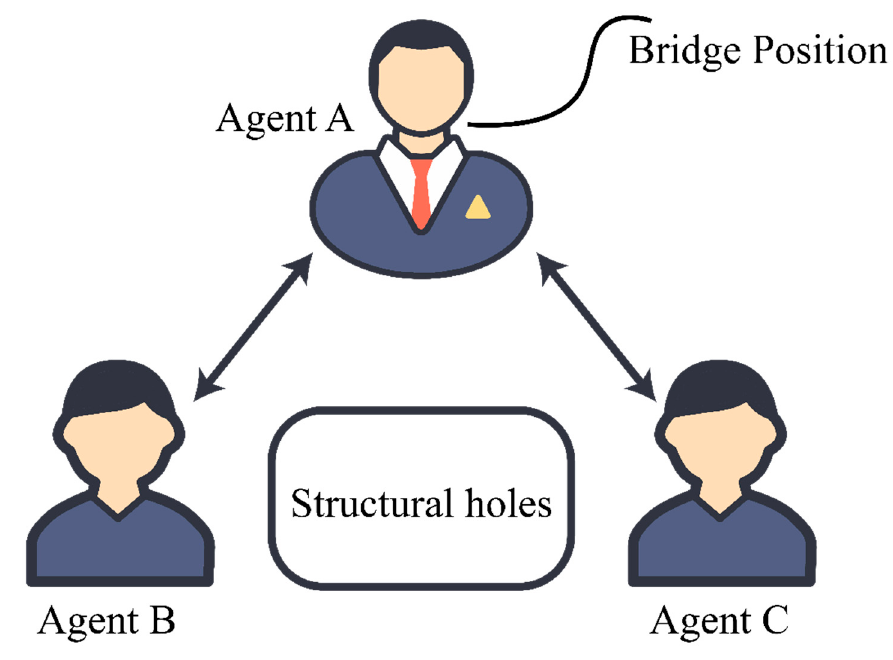
Figure 9. Diagram of structural holes.